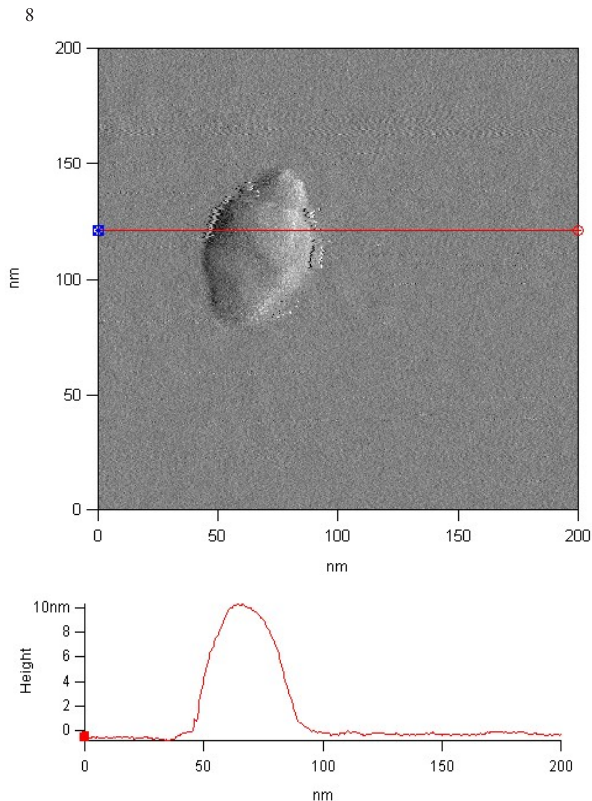
Fig. 1. AFM amplitude image and height section (along the line) of photosynthetic reaction centres purified from Rb. spha- eroides R-26. The average height of the RC is 10±2 nm